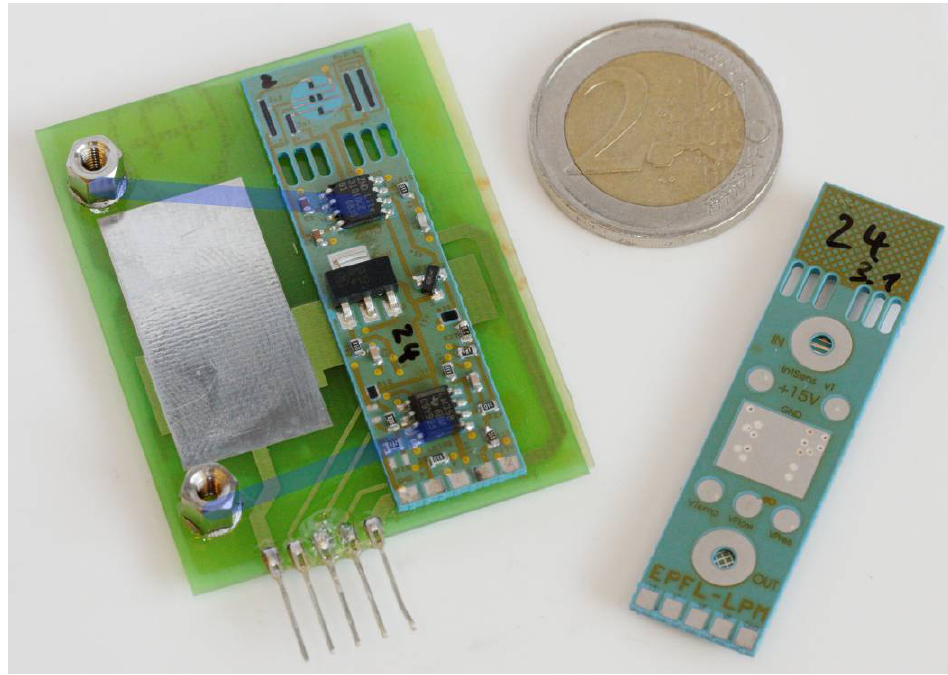
Figure 9. (Left) Integrated sensor mounted on fluidic PCB with channels in transparent blue. ( Right) Bottom face of LTCC sensor showing contact and solder pads, as well as (greenish) overglaze